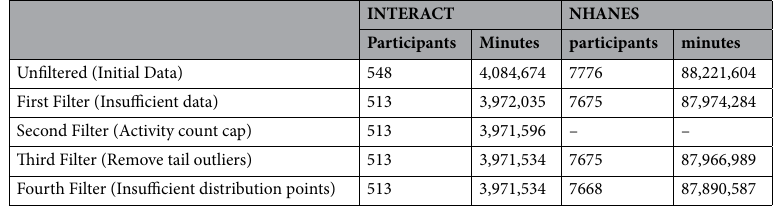
Table 1. Number of participants and minutes remaining after each step in